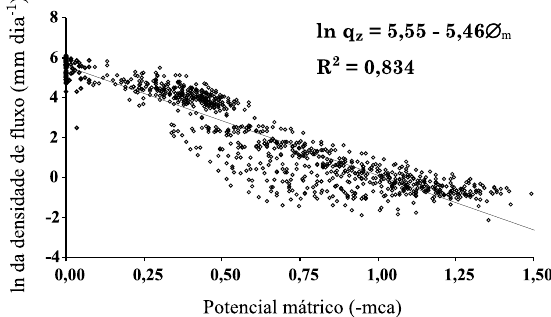
Figura 7. Densidade de fluxo da água (Ln q determinada pela equação (2) (60 repetições) em função do potencial mátrico, para a profundidade de 0,80